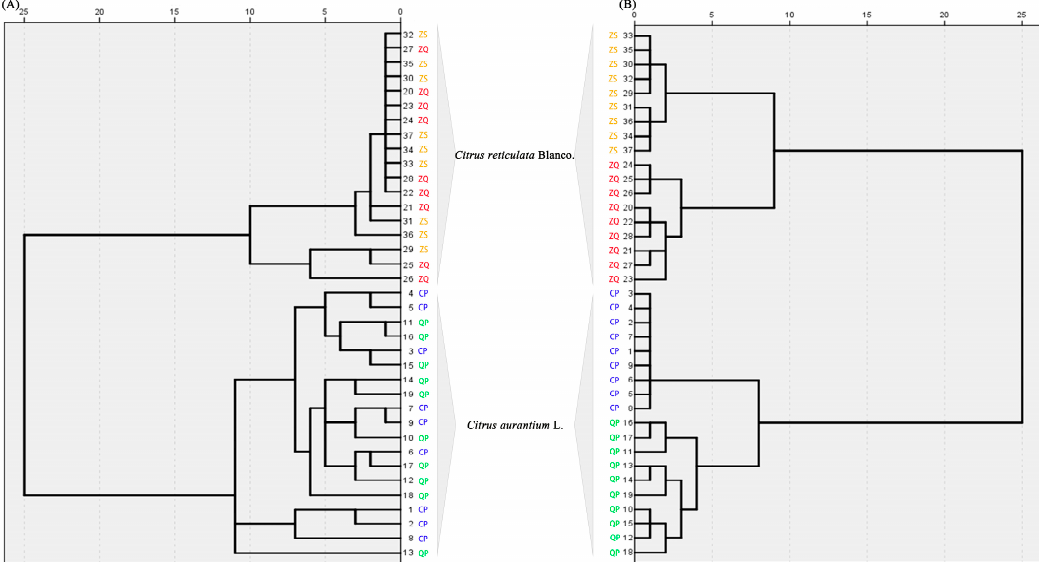
Figure 4. Hierarchical cluster analysis (HCA) of Citrus samples. ( A ) The dendrogram of primary metabolites between the production of Citrus reticulate Blanco and Citrus aurantium L. in the species; ( B ) the dendrogram of secondary metabolites between Citrus samples.